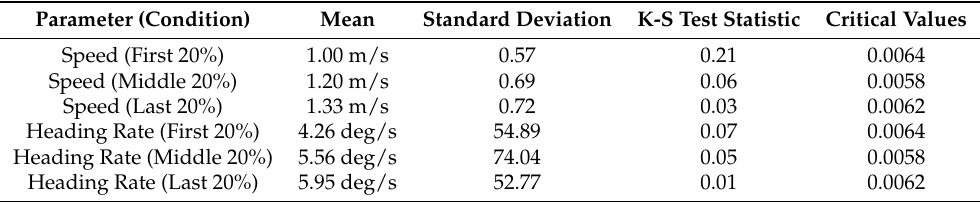
Table 2. Report the statistic of the tracklets’ speed and heading rate for the first 20%, middle 20%, and last 20% time sessions under enrichment condition. All three sessions were compared with the Baseline condition in the K-S